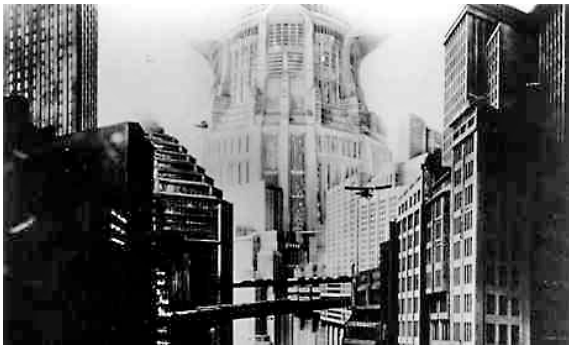
birth to a new creature: the dystopian Asianized me- tropolis of the